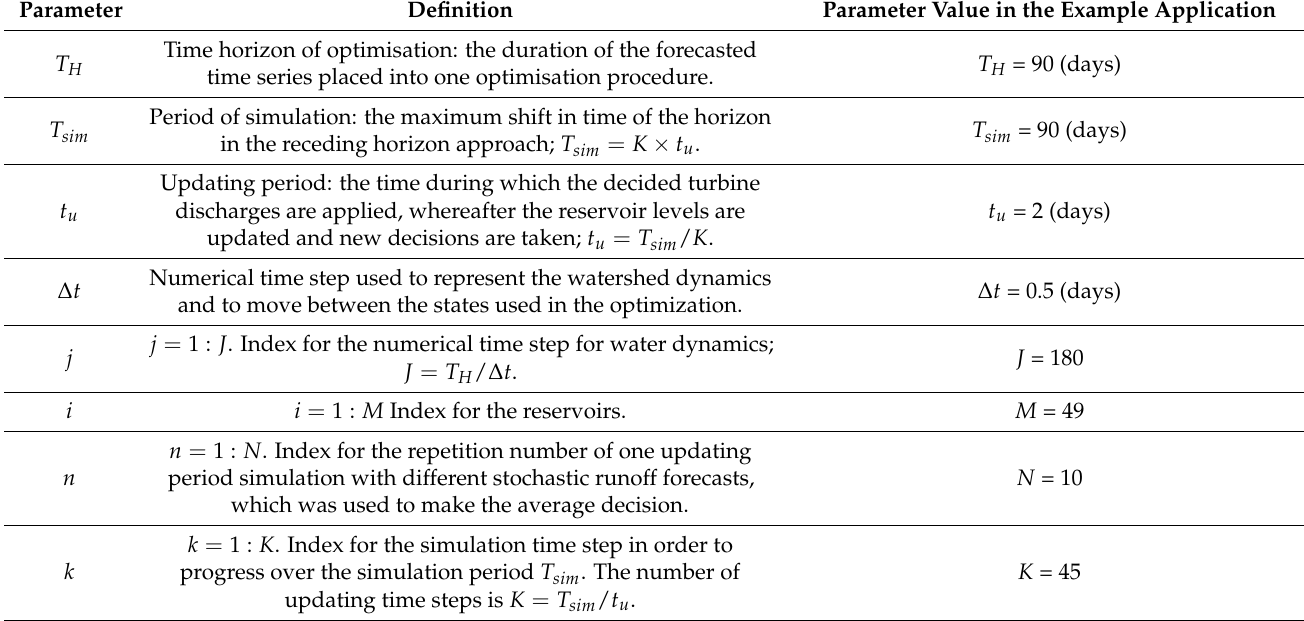
Table 1. List of